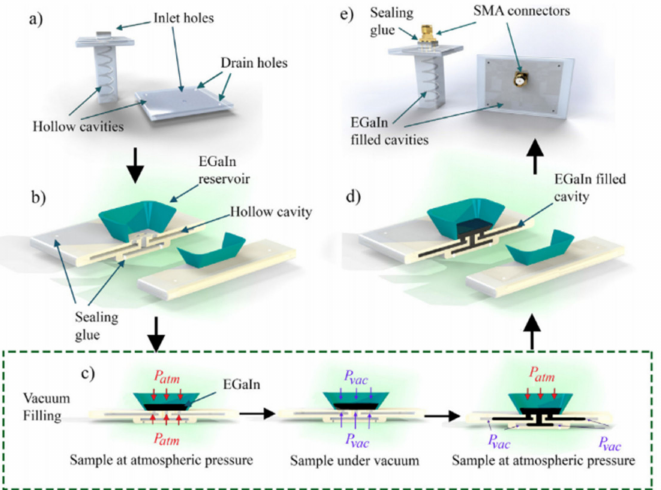
Figure 1. Manufacturing process diagram of liquid metal-filled 3-D printed antenna. ( a ) 3-D printed patch and helix antenna structures with sacrificial wax removed. ( b ) Snap-off liquid storage tank for filling liquid metal and sealing drainage holes. ( c ) The patch antenna is filled with liquid metal under vacuum, and the metal is pushed into the channel by the pressure differential. ( d ) A patch antenna filled with liquid metal. ( e ) Sealing the SMA connectors to finish the antenna manufacturing process. Reprinted with permission from Ref. [25]. Copyright 2017